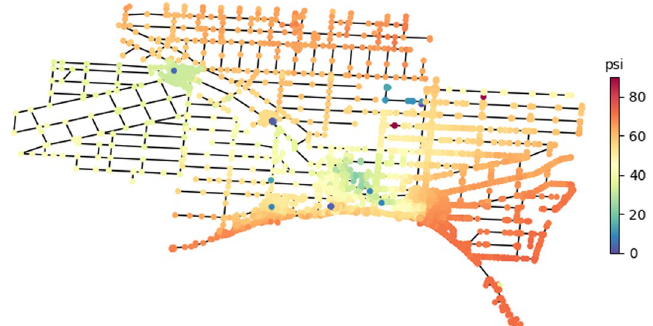
Figure 5. WDN pressure before the occurrence of earthquake and 48 h after the simulation started.